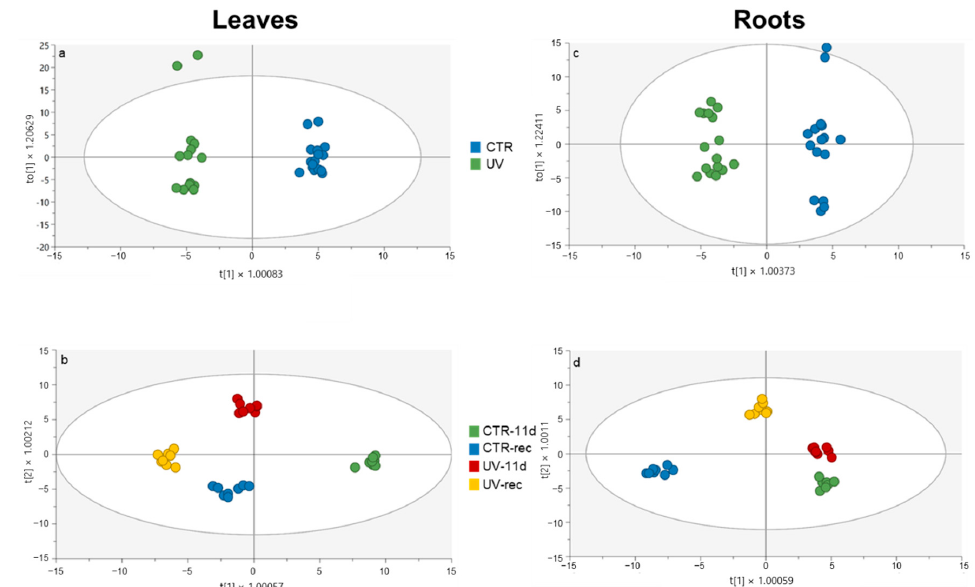
Figure 4. OPLS-DA carried out from the UHPLC-ESI-QTOF phenolic profile of leaves and roots of Micro-Tom tomato plants, considering ( a , c ) UV treatment ( b , d ) UV treatment and time factors. Individual replications are given in the class prediction model score plot.